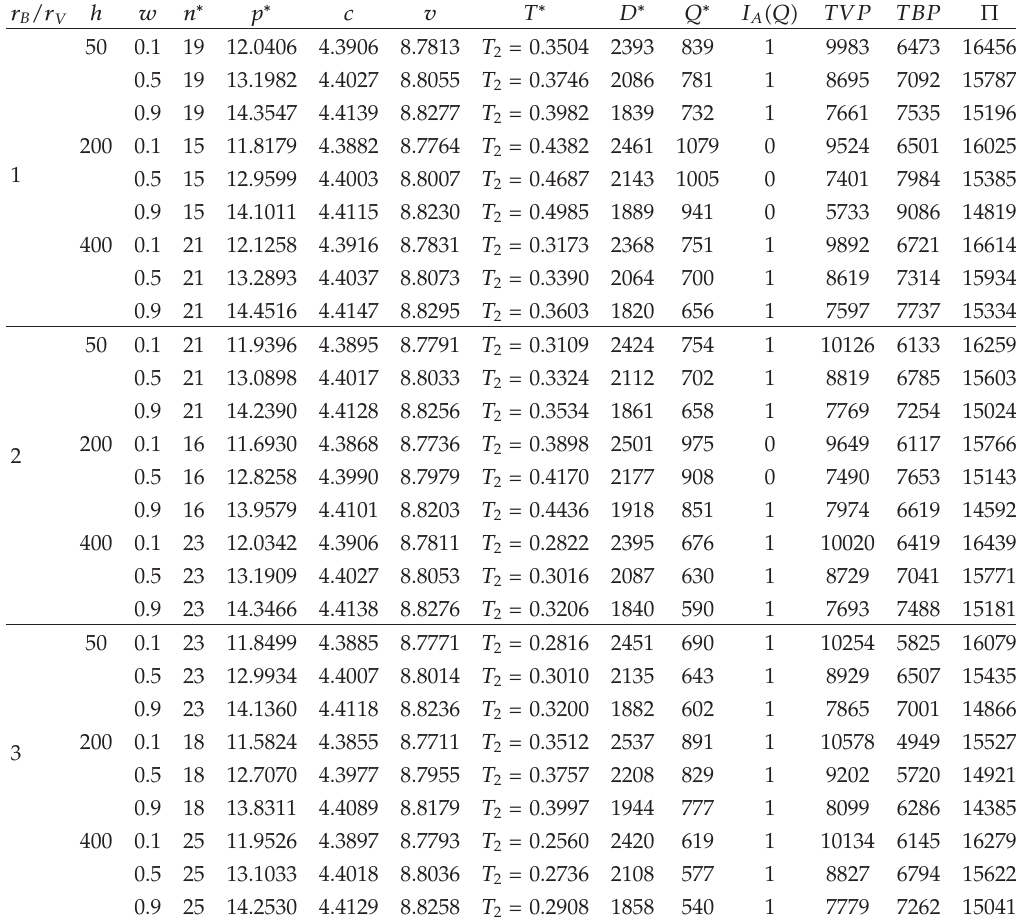
Table 6: The results of sensitivity